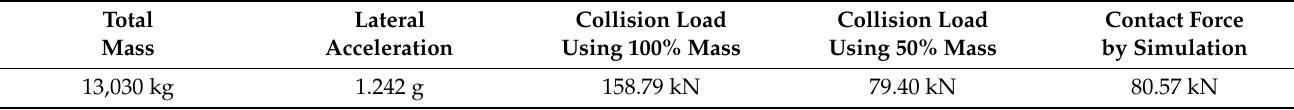
Table 3. Collision load of the 2nd wheel of the front bogie.